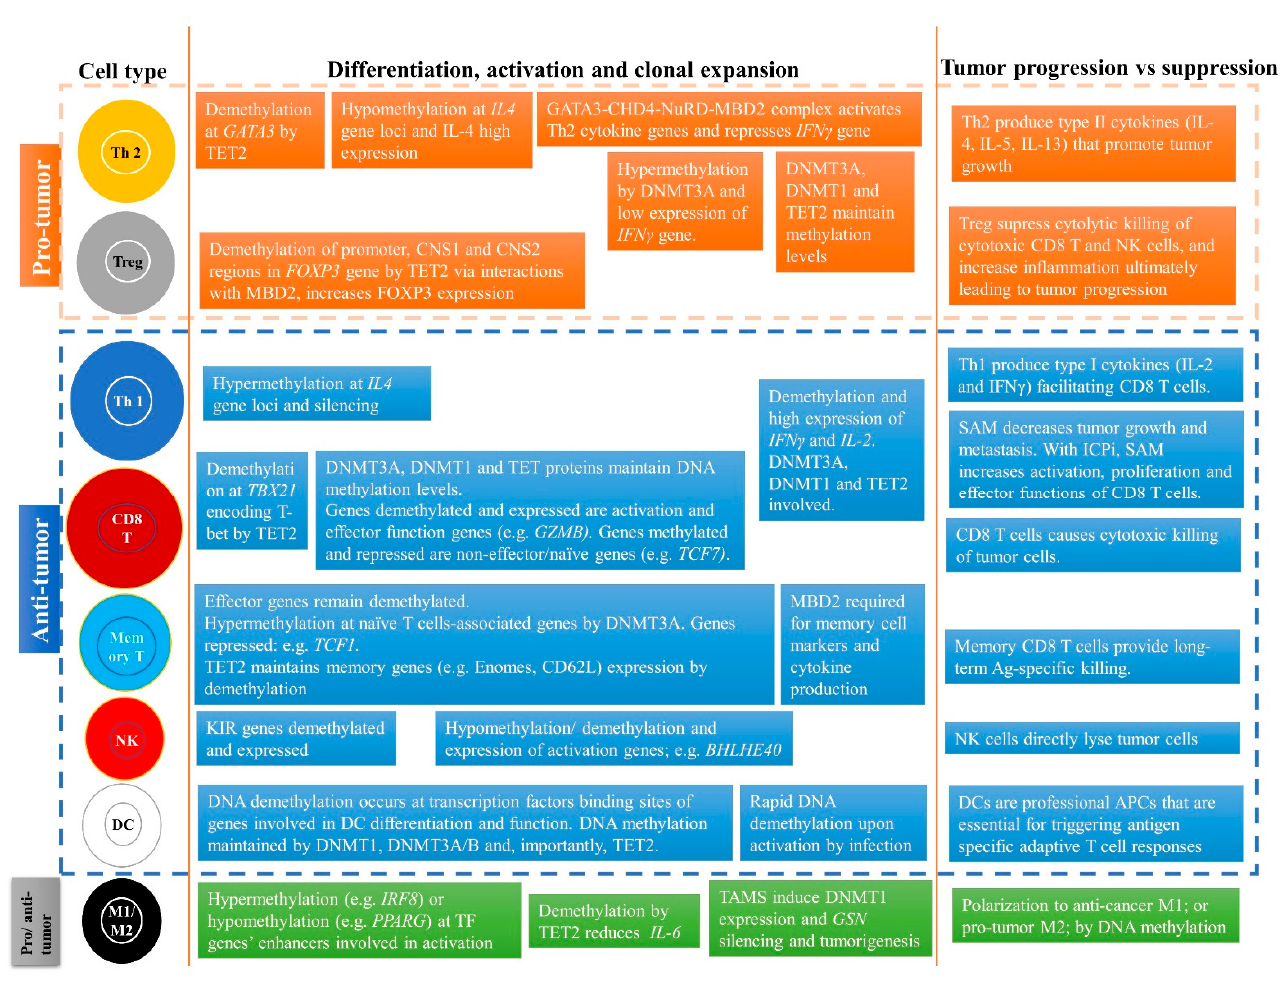
Figure 5. Summary of the role of DNA methylation and co-factor (s-adenosylmethionine, SAM) in regulating differentiation, activation, and proliferation of pro- and anti-cancer immune cells. The pro- or anti-tumor effect of the immune cells in the TME is also described. Abbreviations: Th2, CD4+ helper T cell 2; Tregs, regulatory T cell; Th1, CD4+ helper T cell 1; CD8 T, CD8 cytotoxic T cells; Memory T cells, CD8 memory T cells; NK, natural killer cell; DC, dendritic cell; M1, macrophage M1 subtype; M2, macrophage M2 subtype; TAMS, Tumor associated macrophages; ICPi, Immune checkpoint inhibitors; s-adenosylmethionine, SAM.